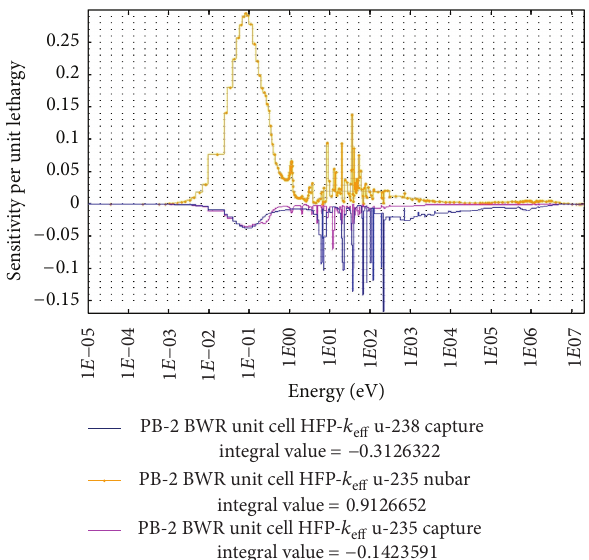
uncertainty for the test cases within Exercise I-1. eff 𝑘𝑘